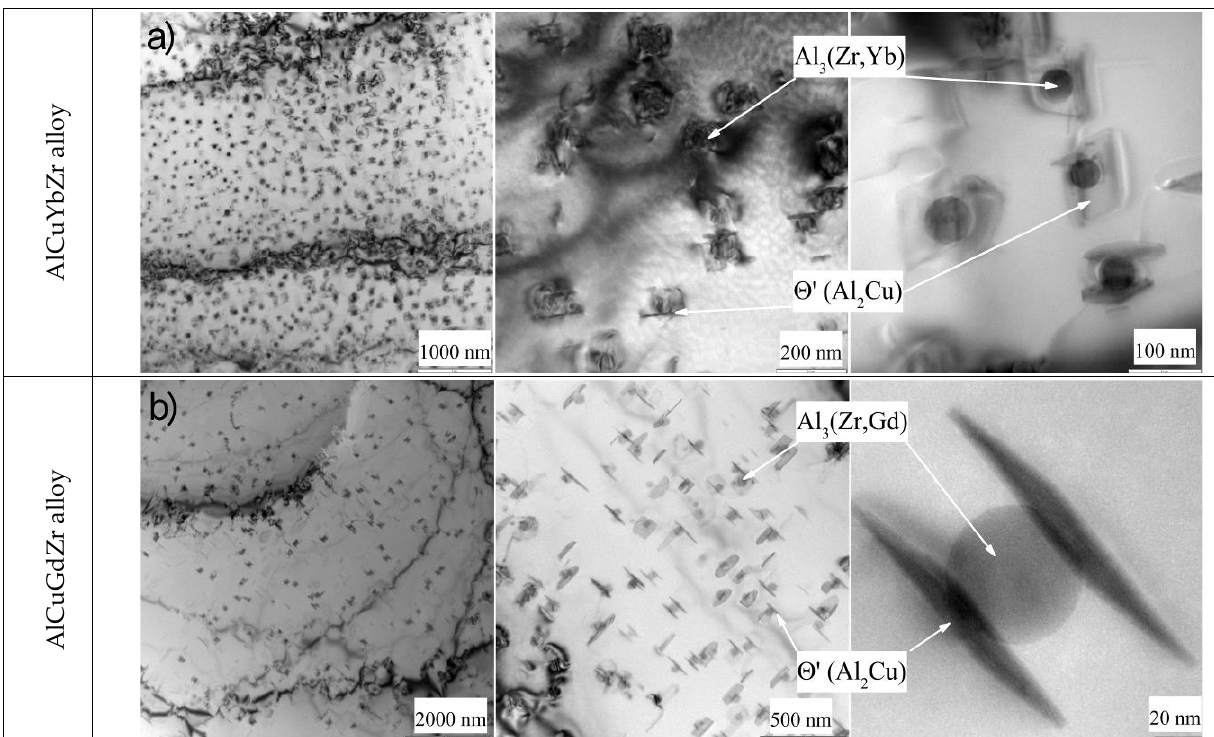
Figure 7. Microstructure (TEM) of the AlCuYbZr ( a ) and AlCuGdZr ( b ) alloys after 6 h of homogenization, quenching, and aging at 210 °C for 3 h.